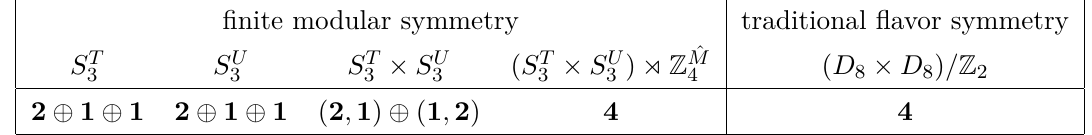
Table 1 . Irreducible representations of twisted matter fields ( φ spect to the various flavor symmetries (in the absence of string oscillator excitations). Open